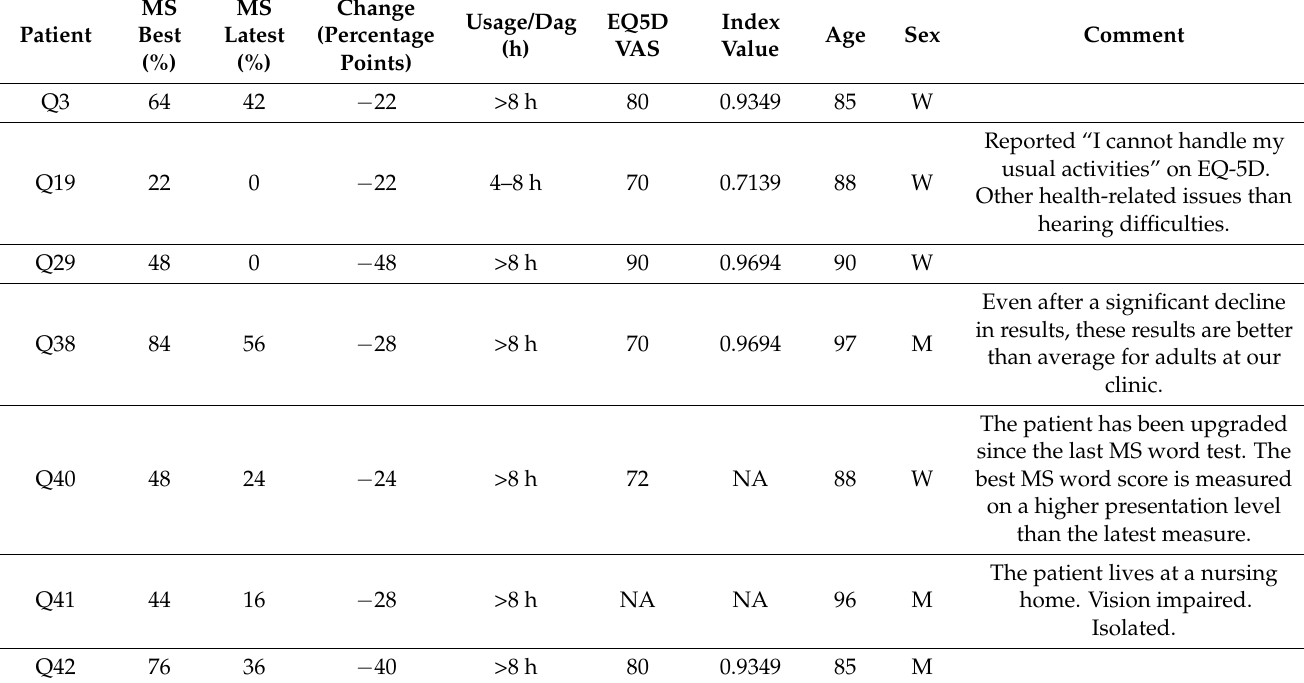
Table 1. Patients with a change in monosyllabic score of more than 20 percentage points between best and latest measure, their daily CI usage, EQ5D VAS score, index value (NA = no answer), age, and sex.